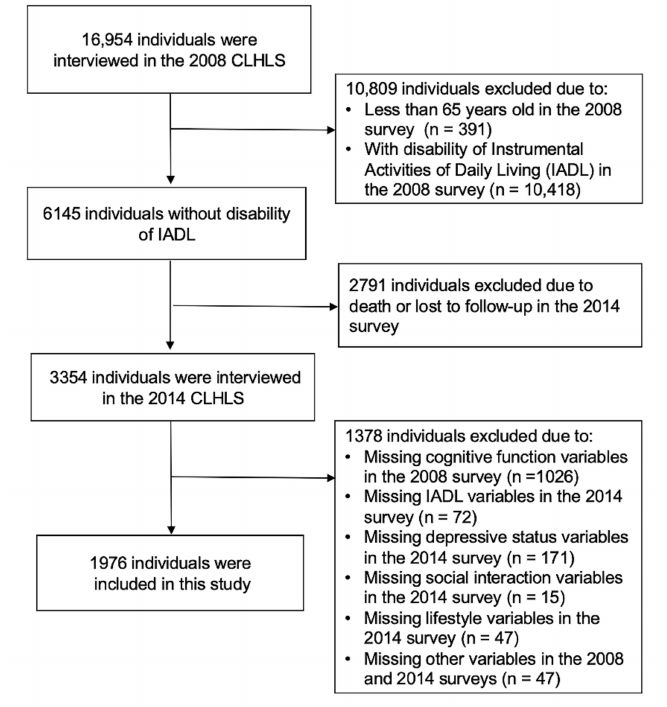
Figure 1. Flowchart of inclusion and exclusion of participants in the